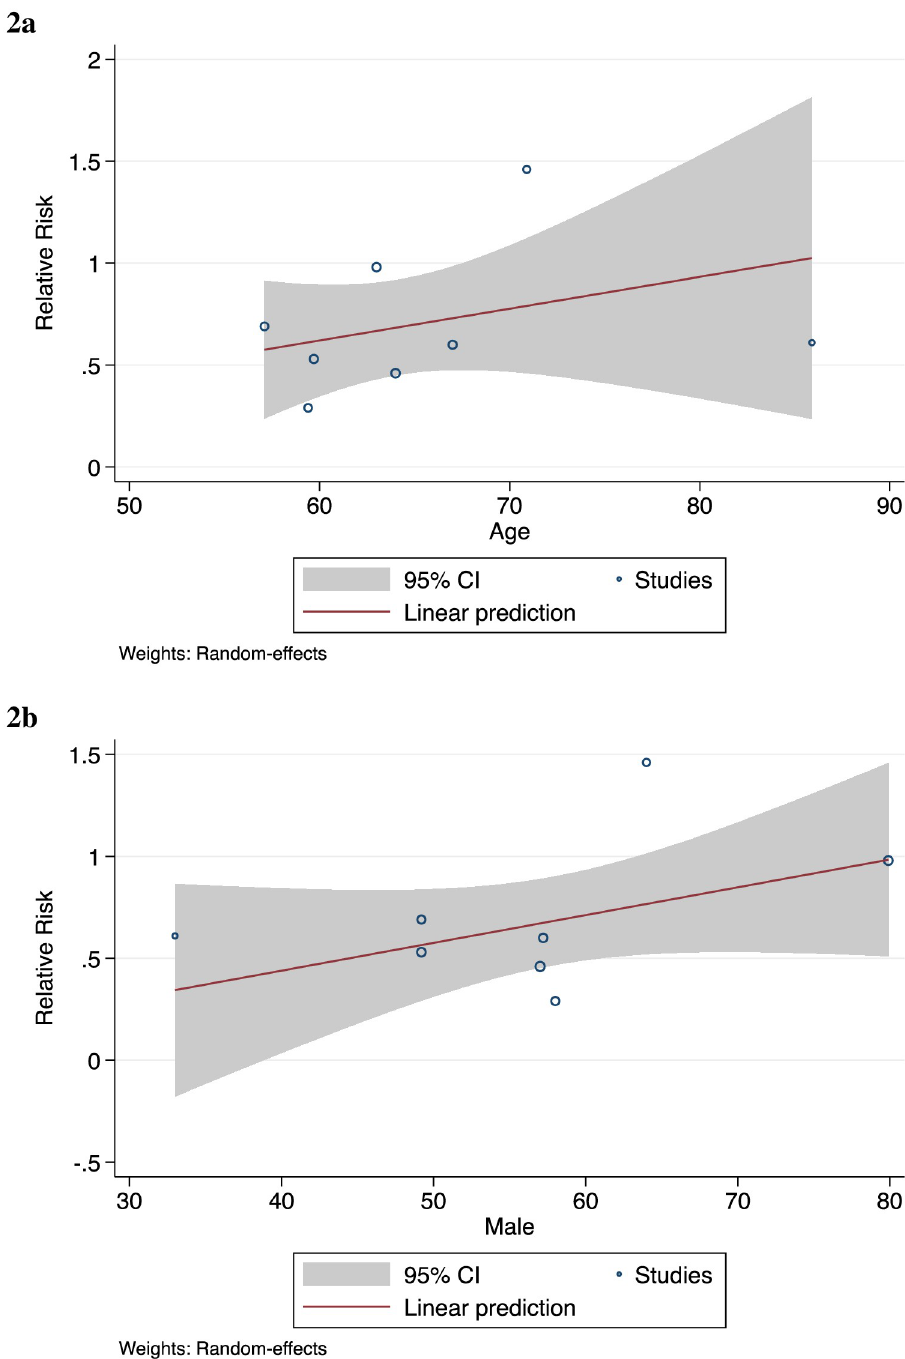
Fig 2. Statin use before hospitalization. a By Age ( β = 0.02; p = 0.38) b By Percentage Male ( β = 0.01; p = 0.16).